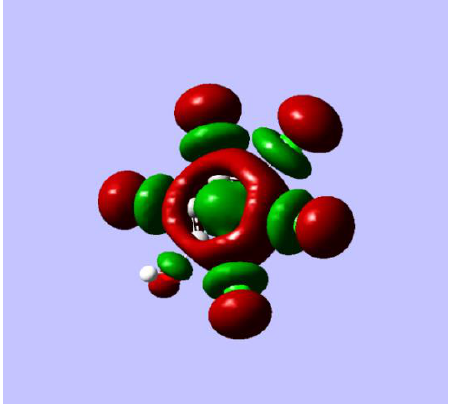
Figure 7. Graphical representation of the energies present in the HOMO and LUMO boundary orbitals of the Pentachlorophenol molecule (optimized by GaussView® software (ver.5.0).